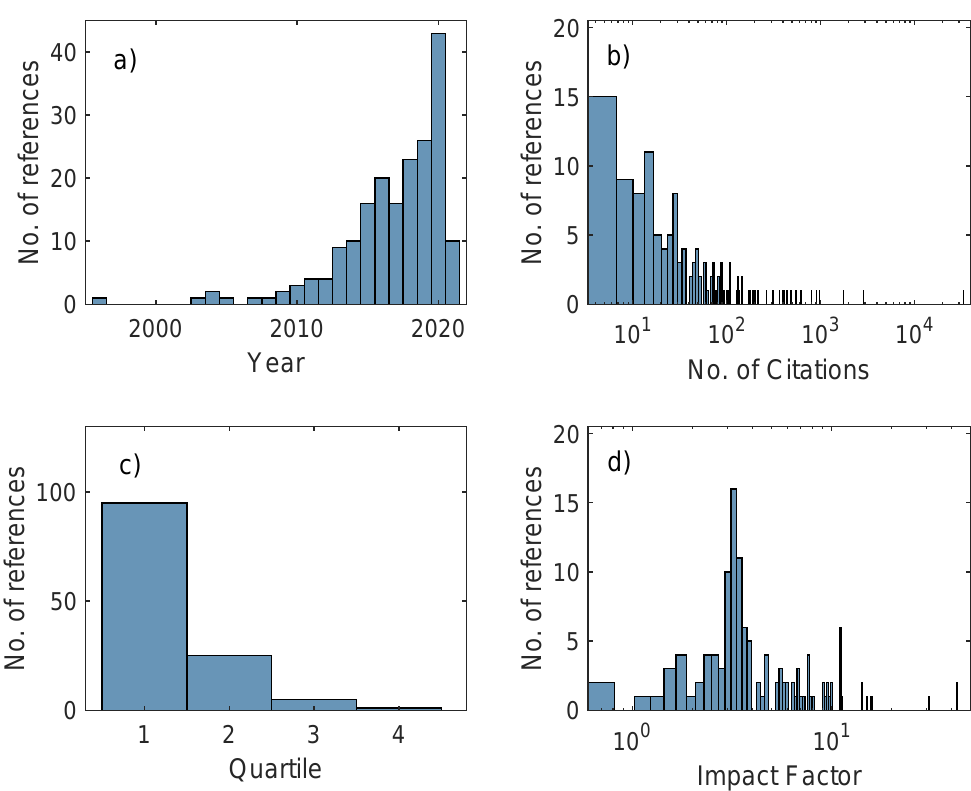
Figure 1. Histograms showing the distributions of different features of the papers selected for this review: ( a ) Year, ( b ) Number of citations, ( c ) Journal Quartile and ( d ) Journal Impact Factor.